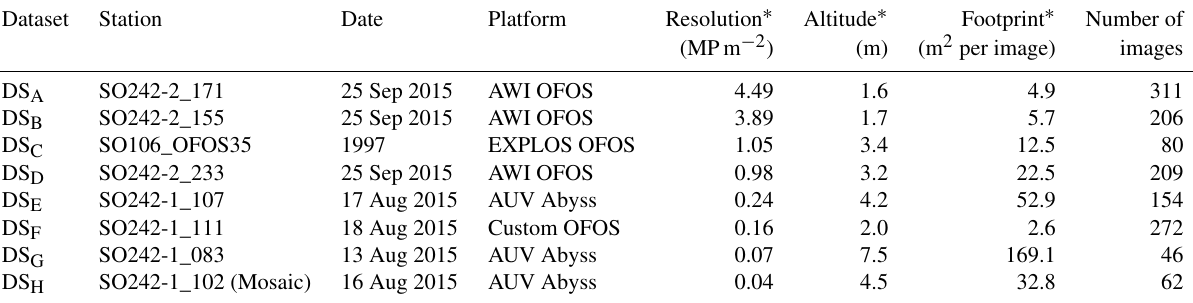
Table 1. Summary of image data collected for each dataset considered in this study. Columns marked by ( ∗ ) represent median values across the dataset.